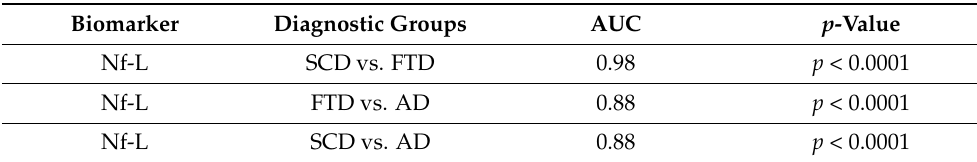
Table 4. AUC and p -values of ROC curves comparing the diagnostic value of CSF Nf-L between clinical groups.